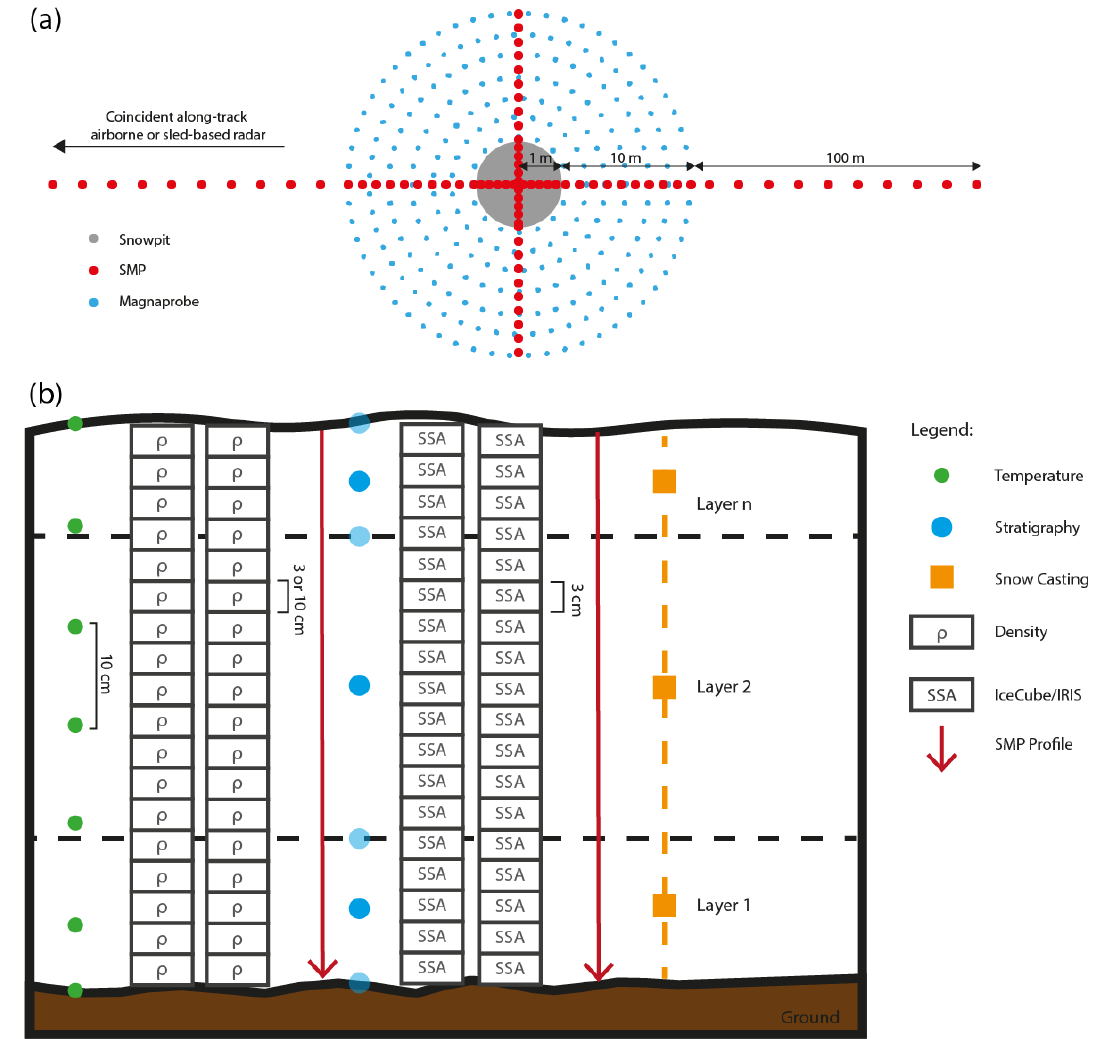
Figure A1. Optimal measurement configurations for evaluation of snow properties in sensor